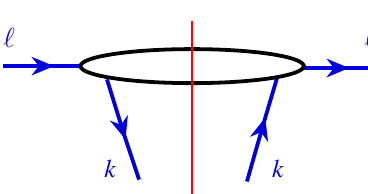
Figure 4 . Sketch of the lepton distribution function for finding a fermion (quark or lepton) inside a colliding lepton of momentum ‘ , where the active fermion of momentum k in the amplitude and its complex conjugate is contracted by the cut-vertex, γ + / (2 ‘ + ) δ ( ξ − k + /‘ + )